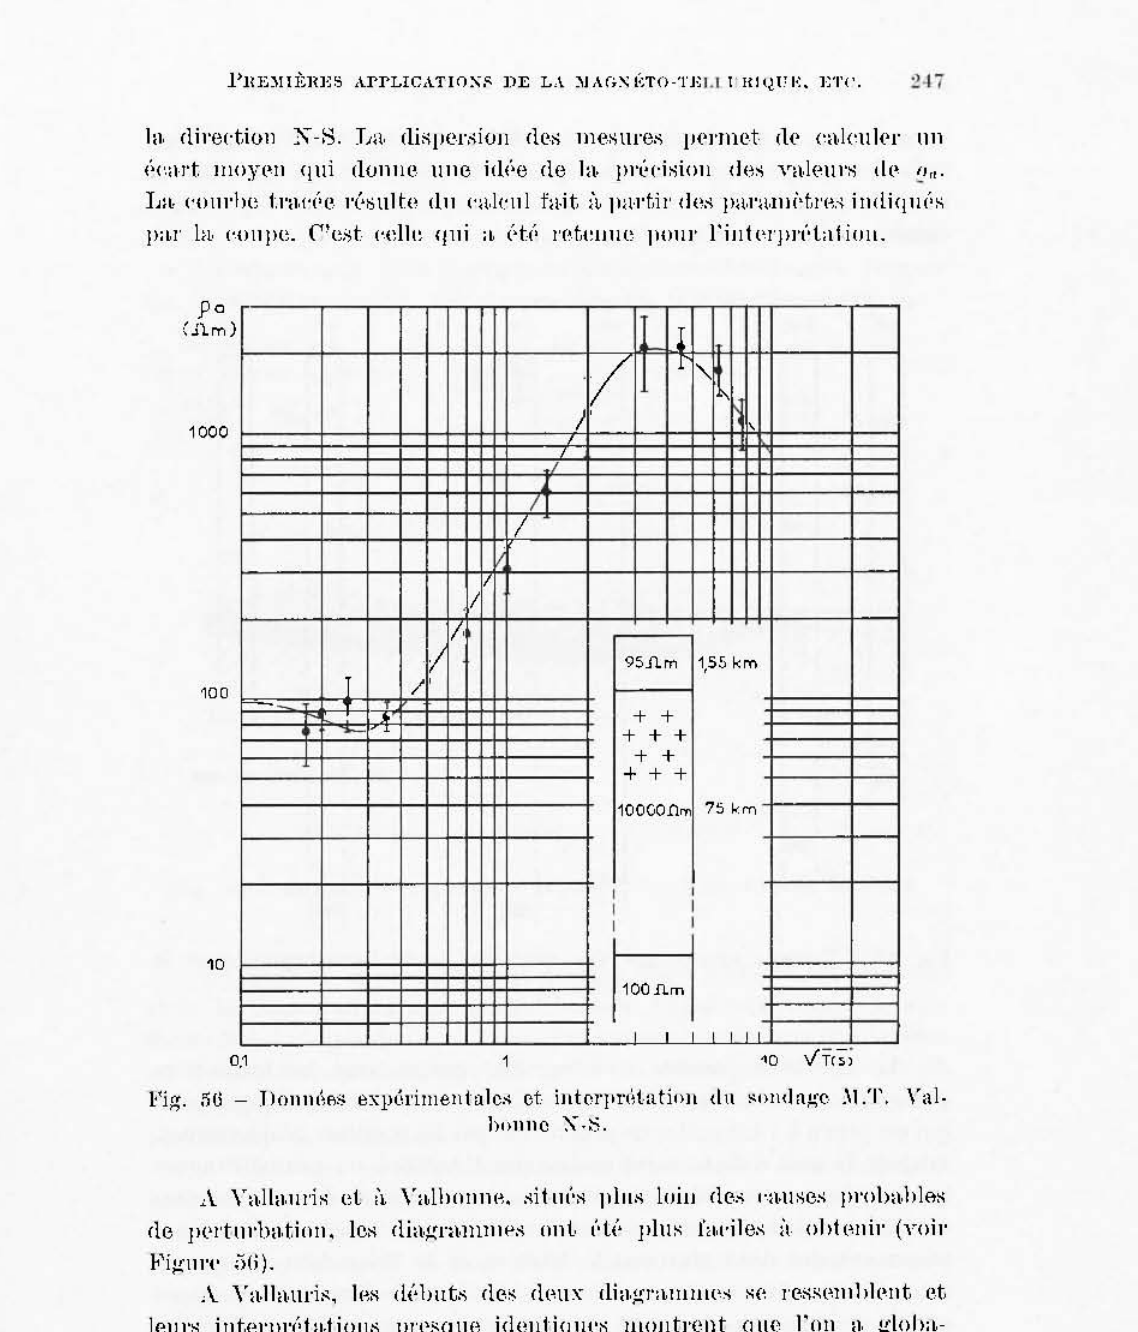
Fig. ,~{j - J)Ol1l1Mli! expl'l'illlelltlllc.~ ct illterl'rMlItioll da ~olldrtl;'c .\1.'1', \'al. h01111C X